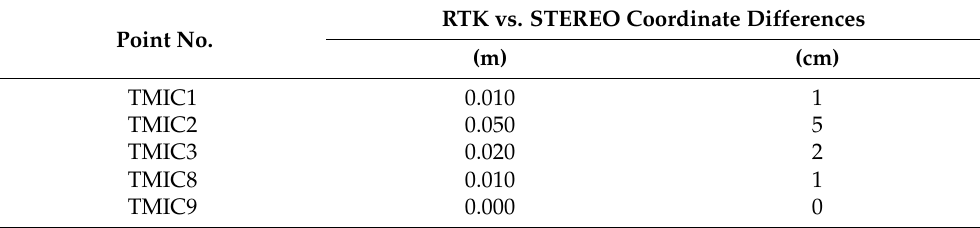
Table 13. Coordinate differences between KINEMATIC (RTK) and STATIC measurements, resulting from field measurements and post-processing in AutoCAD.